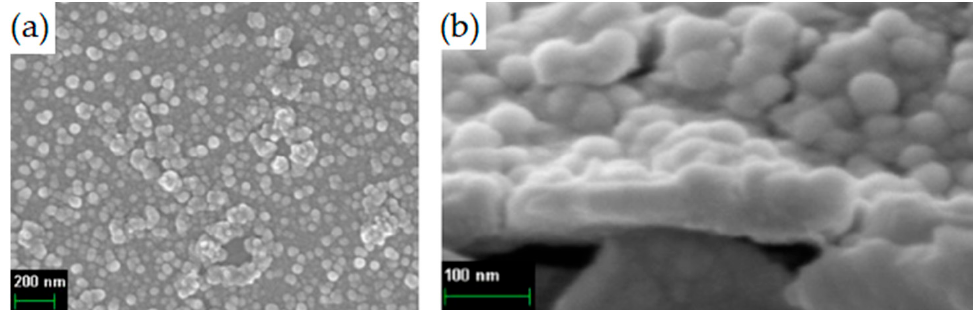
Figure 7. SEM of the surface ( a ) and cleavage ( b ) of the Ta-O_6 sample on a steel substrate.